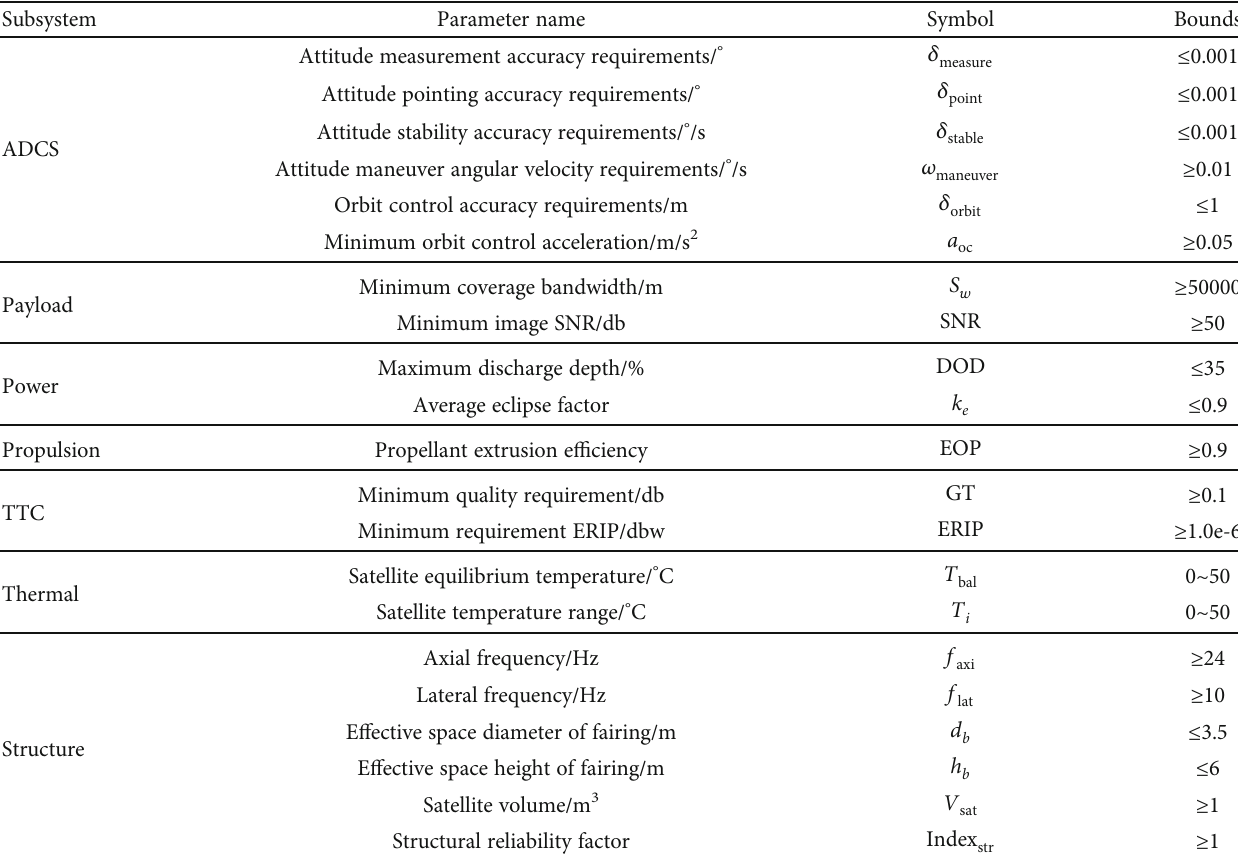
Table 2: Subsystem level constraints.